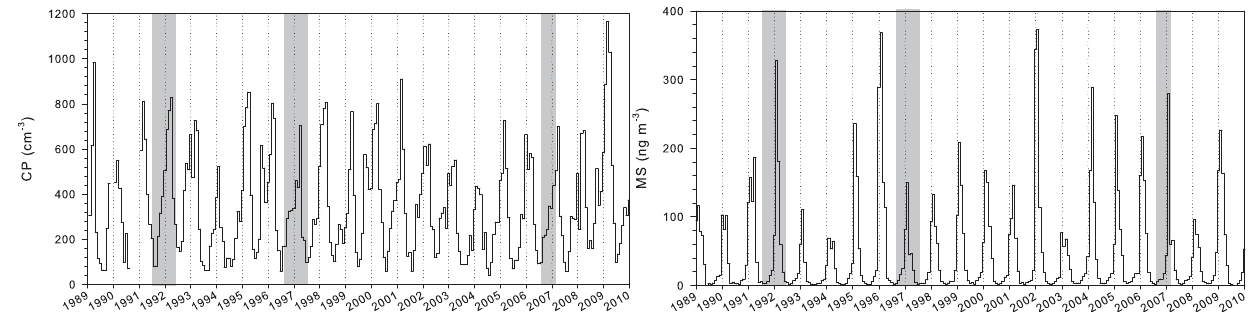
Fig. 2. Condensation particle time series (a) and methane sulfonate (MS) record from NM (b) , both displayed in monthly mean bins. Shaded grey areas: El Ni˜no events (1997 and 2006) and eruption of Mt. Pinatubo (1991).